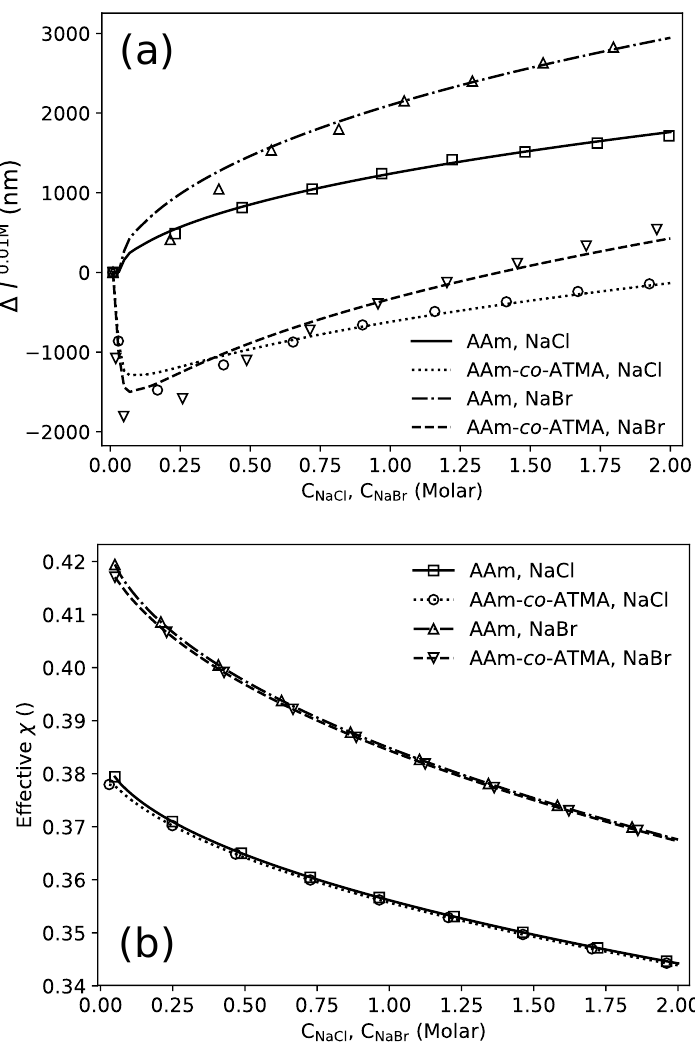
Figure 5. Results obtained through a constrained fit assuming the same Nv value for all gels. ( a ) Comparison between simulation results (lines) and experimental equilibrium data (markers) for all four experiments and ( b ) Effective values of χ as a function of concentration of NaCl or NaBr in aqueous solution for the optimized parameters for AAm and AAm- co -ATMA, 3 mol%